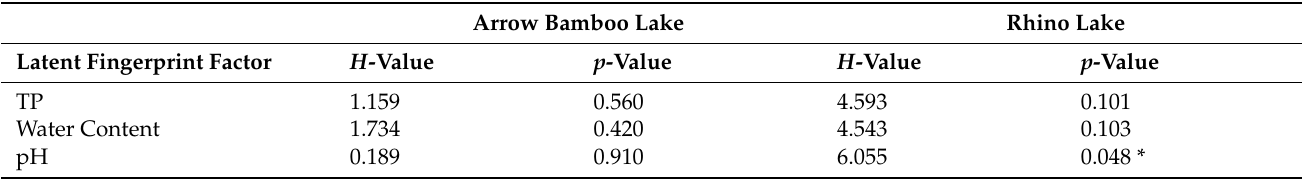
Table 1. Results of the Kruskal–Wallis H-test at Arrow Bamboo and Rhino Lakes. Arrow Bamboo Lake Rhino